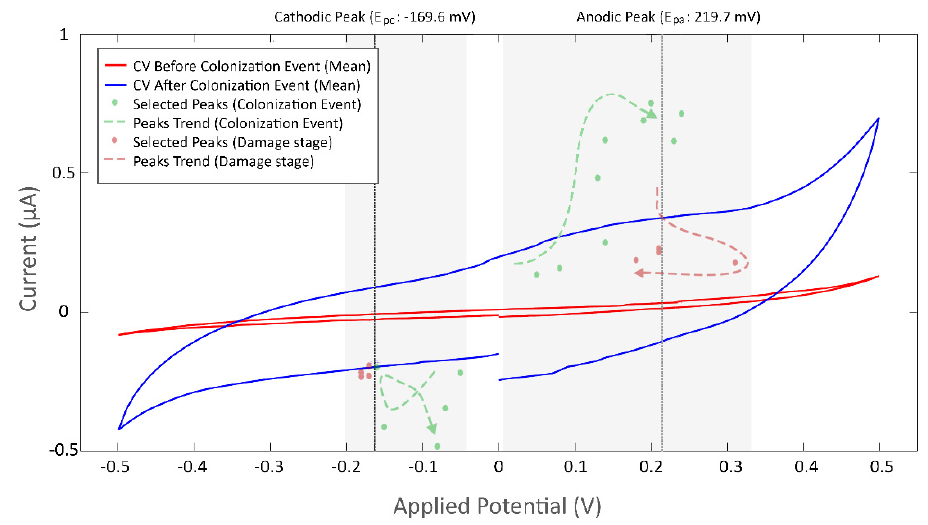
Figure 11. Identification of current peaks for a selected measure. Bacterial colonization was detected 4 h after initialization of the experiment and confirmed with images. Electrode damage was observed after 9 h. Mean values of a recorded cyclic voltammogram measurement before (red) and after (blue) the bacterial colonization event. Selected peaks are shown for the colonization event (green dots) and the damage stage (red dots), which was observed after 29 h. Peak trends are shown as dashed arrows for the colonization event (green arrow) and the damage stage (red arrow).